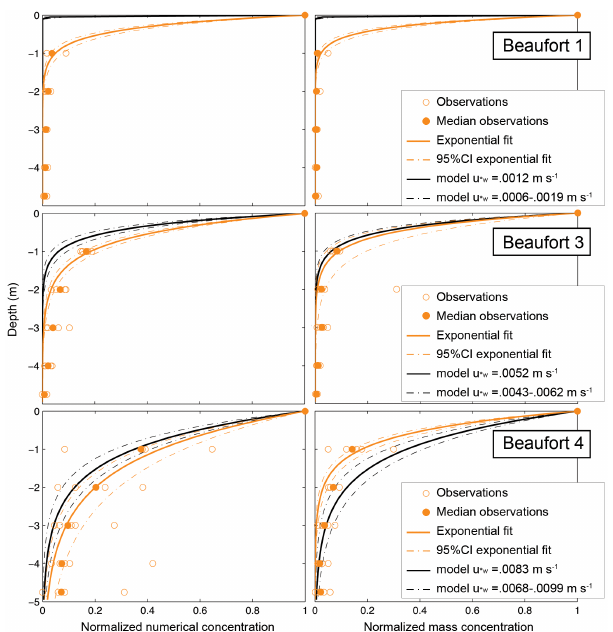
Figure 3. Depth profiles of normalised plastic numerical and mass concentrations under different Beaufort numbers: 1 ( N = 3 net tows; 3283 plastic pieces), 3 ( N = 4 net tows; 4049 plastic pieces), and 4 ( N = 5 net tows; 5419 plastic pieces). Black lines show model predictions (Kukulka et al., 2012) using median plastic rise velocity (0.0053ms − 1 ), and the typical range of frictional velocity of water ( u ∗ w ) at each of the sea states sampled.